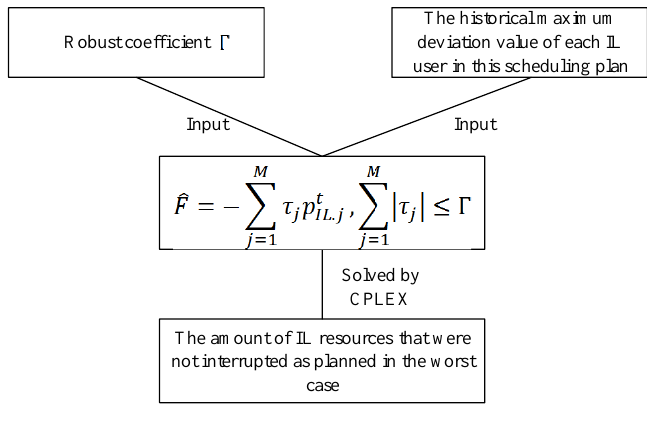
Figure C1. Sketch map of IBDR. Figure A2. Sketch map of